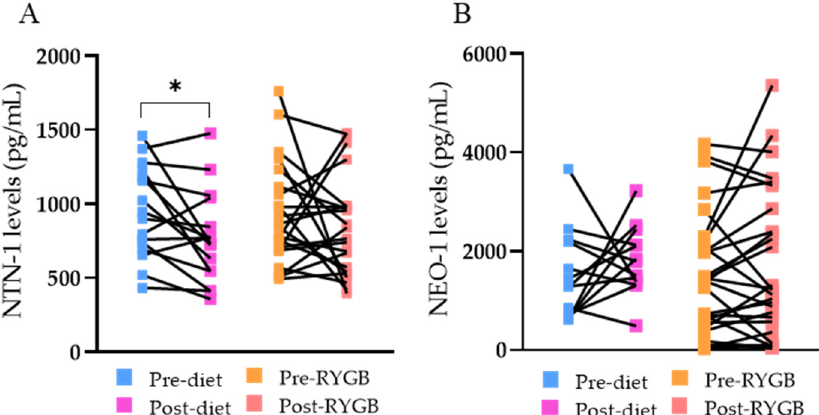
Figure 1. ( A ) Circulating levels of netrin (NTN)-1 before and after weight loss achieved by a conventional diet ( n = 16) or Roux-en-Y gastric bypass (RYGB) ( n = 22). ( B ) Circulating levels of neogenin (NEO)-1 before and after weight loss achieved by a conventional diet ( n = 13) or Roux-en- Y gastric bypass (RYGB) ( n = 28). Differences between groups were analyzed by unpaired Student’s t -test. * p <